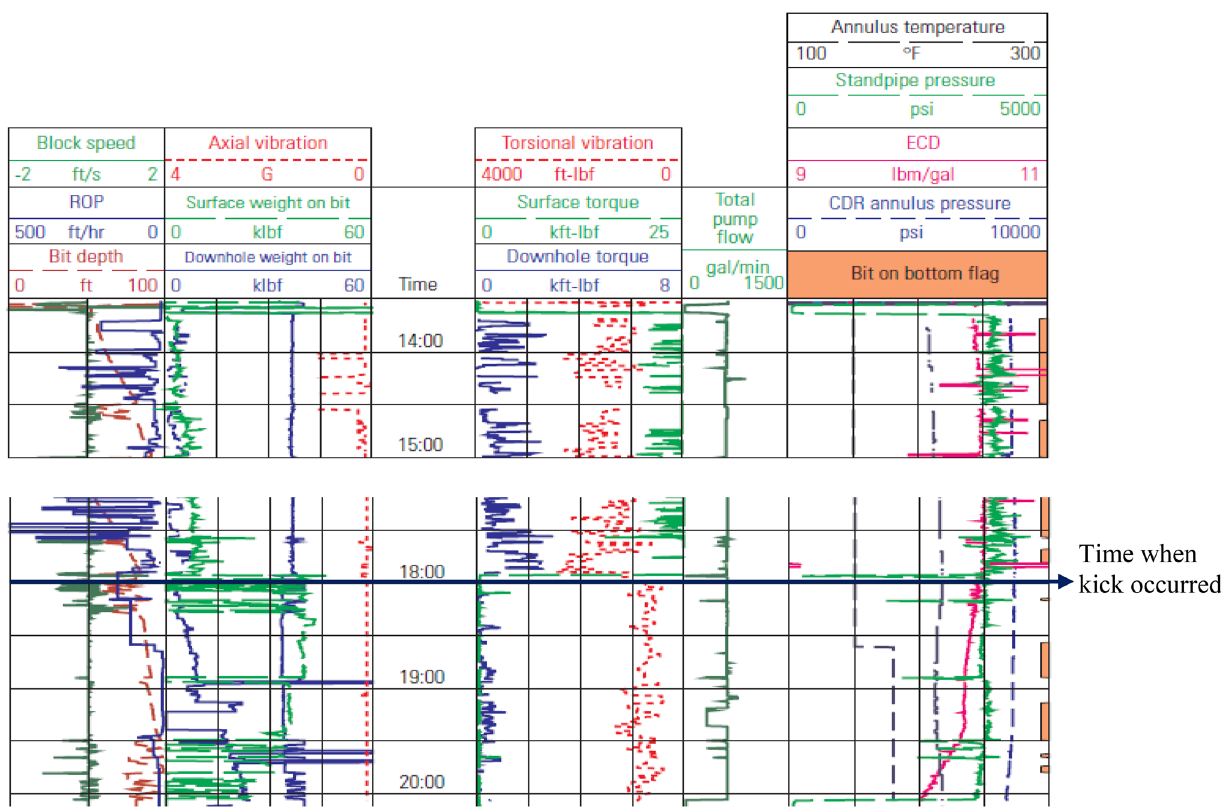
Fig. 5 Reproduced well log with respect to time showing the kick alert in the GOM well (Source: Aldred et al. 1998)